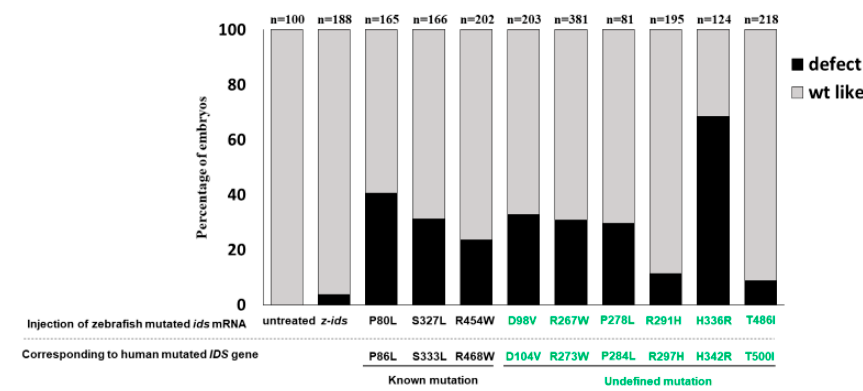
Figure 4. The percentage of defective phenotypes occurring in all examined embryos injected with di ff erent mutant forms of z- ids mRNAs. Embryonic phenotypes were examined at 5 dpf in the zebrafish embryos injected at one-cell stage with 300-pg zebrafish ids mRNAs (z- ids ), including mutated variants, as indicated. Each mutated ids gene of the zebrafish corresponds to a human mutated IDS gene, as listed below. The occurrence rates (in percentages) of the defective phenotypes (marked in dark boxes) and the wild-type-like phenotype (marked in grey) among the total examined embryos injected with di ff erent mRNAs were calculated. The total number (n) of embryos studied in each injection group was indicated on the top of each column.